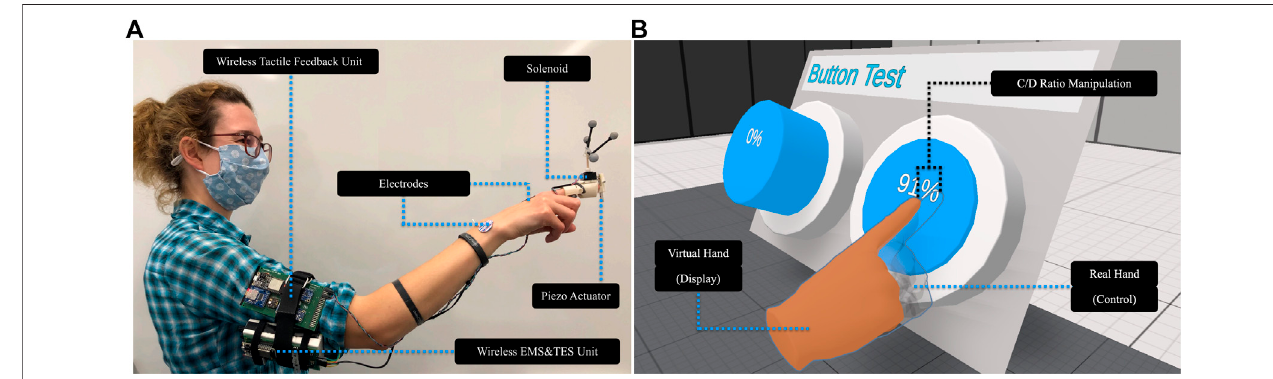
FIGURE 1 | Holistic approach to convey touch illusions by combining pseudo-haptics with haptic feedback to interact with a 3D button in VR. (A) Our wearable device provides tactile and proprioceptive feedback to convey the sensations of contact and activation, by providing tapping plus tendon electrical stimulation, and